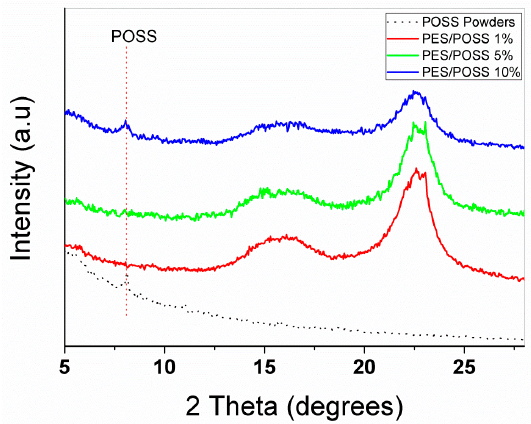
Figure 4. XRD patterns of electrospun PES containing variable wt % of POSS (solid line). The POSS